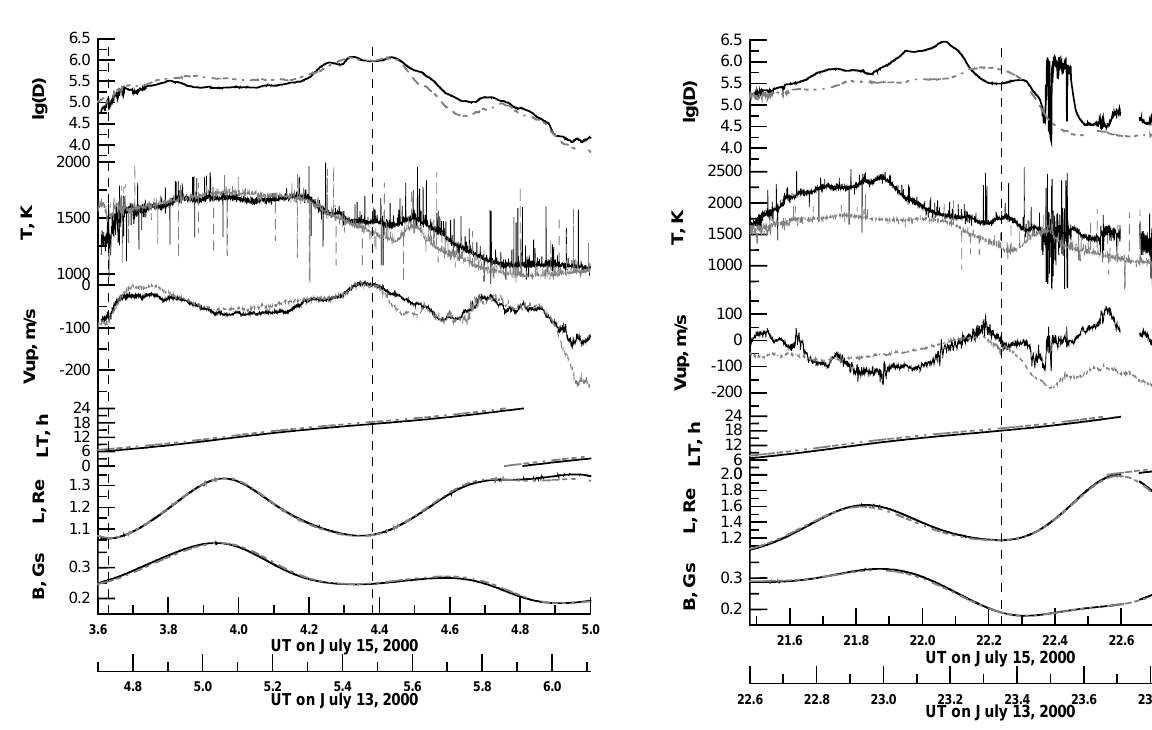
Fig. 3. Comparison of storm-time ionospheric disturbances on 15 July (black solid line) with quiet conditions on 13 July (gray dashed lines) for overlapping orbits of the ROCSAT-1 satellite (from top to bottom): ion density in logarithmic scale, ion temperature and upward velocity, local time, L-shell, and magnetic field strength. Vertical dashed line depicts the geomagnetic equator. The dis- turbed ionospheric conditions are substantially different from the quiet